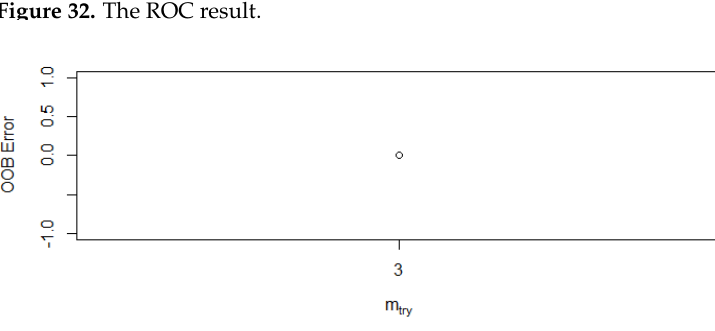
Figure 32. The ROC result.